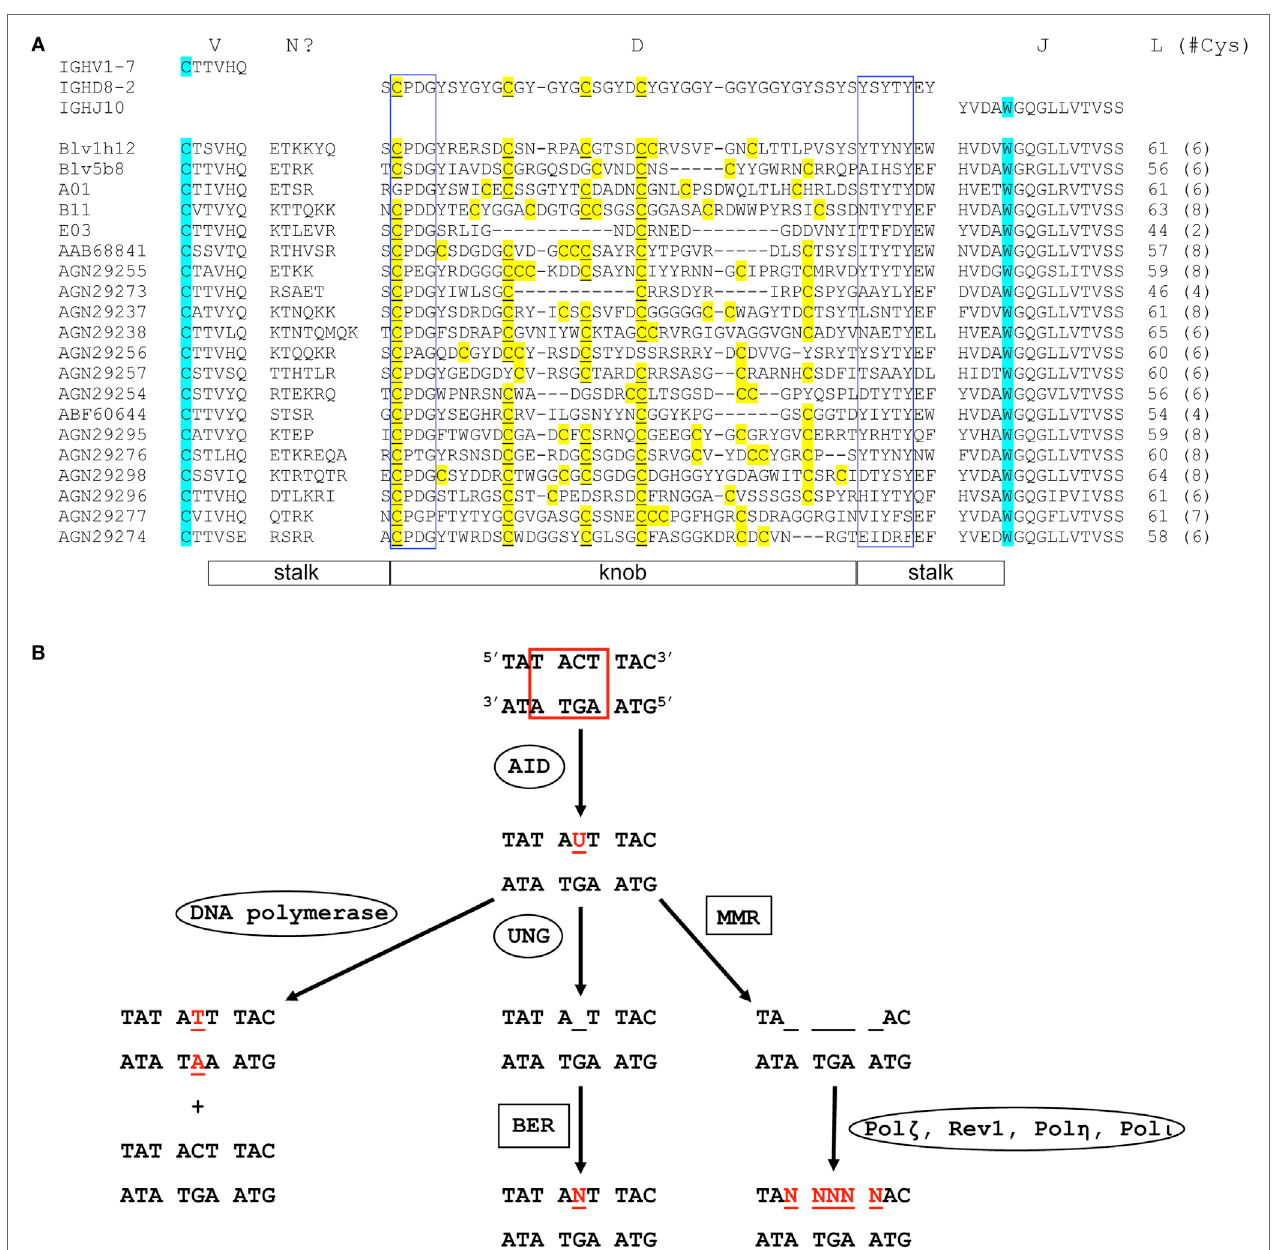
FiGUre 2 | Sequence diversity and genetic mutation in ultralong complementarity determining region (CDR) H3 regions. (A) Alignment showing diversity of bovine ultralong CDR H3. Residues encoded by germline IGHV1-7, IGHD8-2, and IGHJ10 are shown on the top of the alignment for reference. The start and the end of the CDR H3 are defined by the conserved cysteine and tryptophan which are colored turquoise. N ? indicates residues possibly encoded by terminal deoxynucleotidyl transferase catalyzed N additions or conserved short nucleotide sequence insertions at the V–D junction. Cysteine residues in the D region are colored yellow and the unmutated germline-encoded cysteines are also underlined. The conserved CPDG and YxYxY motifs near the beginning and the end of the D region are enclosed in blue boxes, respectively. The length of each CDR H3 and the number of cysteine residues (in parenthesis) it contains is shown on the right of the alignment. The stalk and knob regions are indicated below the alignment. The alignment was performed using MAFFT, then manually adjusted to align the conserved residues. The first five sequences with crystal structures available are named according to published nomenclature, and the remaining sequences are named with their GenBank accession numbers. (B) Mutation induction by AID. AID deaminates cytosine to uracil at an AID hotspot (boxed in red). This can be followed by three different processes that cause point mutations. DNA polymerase replicates in both strands of parental DNA, resulting in two daughter strands, one with a C to T mutation and one without (Left). Uracil-DNA glycosylase removes uracil, creating an abasic site (Middle). Error-prone base excision repair can then replace this site with any dNTP ( N = A, C, G, or T). Mismatch repair removes several nucleotides around and including the uracil (right). This is then followed by error-prone DNA polymerases, which can cause a mutation at any of the sites, where nucleotides have been removed (Ovals designate single enzymes and squares designate multi-enzyme processes). Mutated nucleotides are shown in